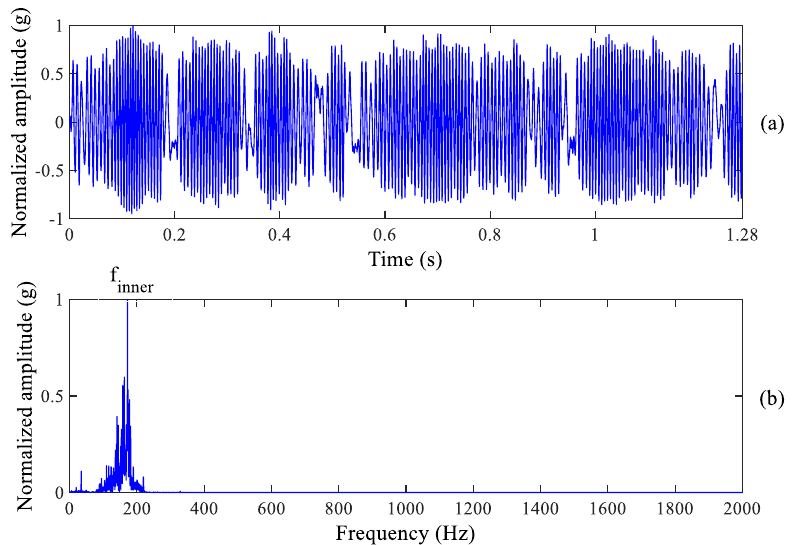
Figure 7. Inner race wear diagnosis result: ( a ) Enhanced signal ( b ) Zoomed frequency spectrum .